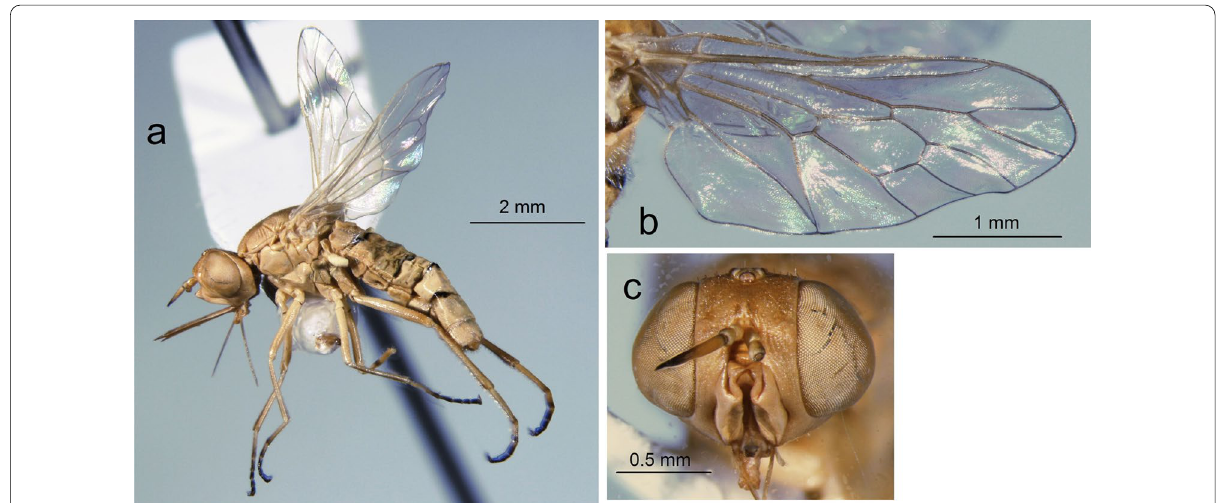
Fig. 3 Heterotropus xanthothorax Efflatoun. a Female habitus, lateral view. b Wing. c Head, frontal view